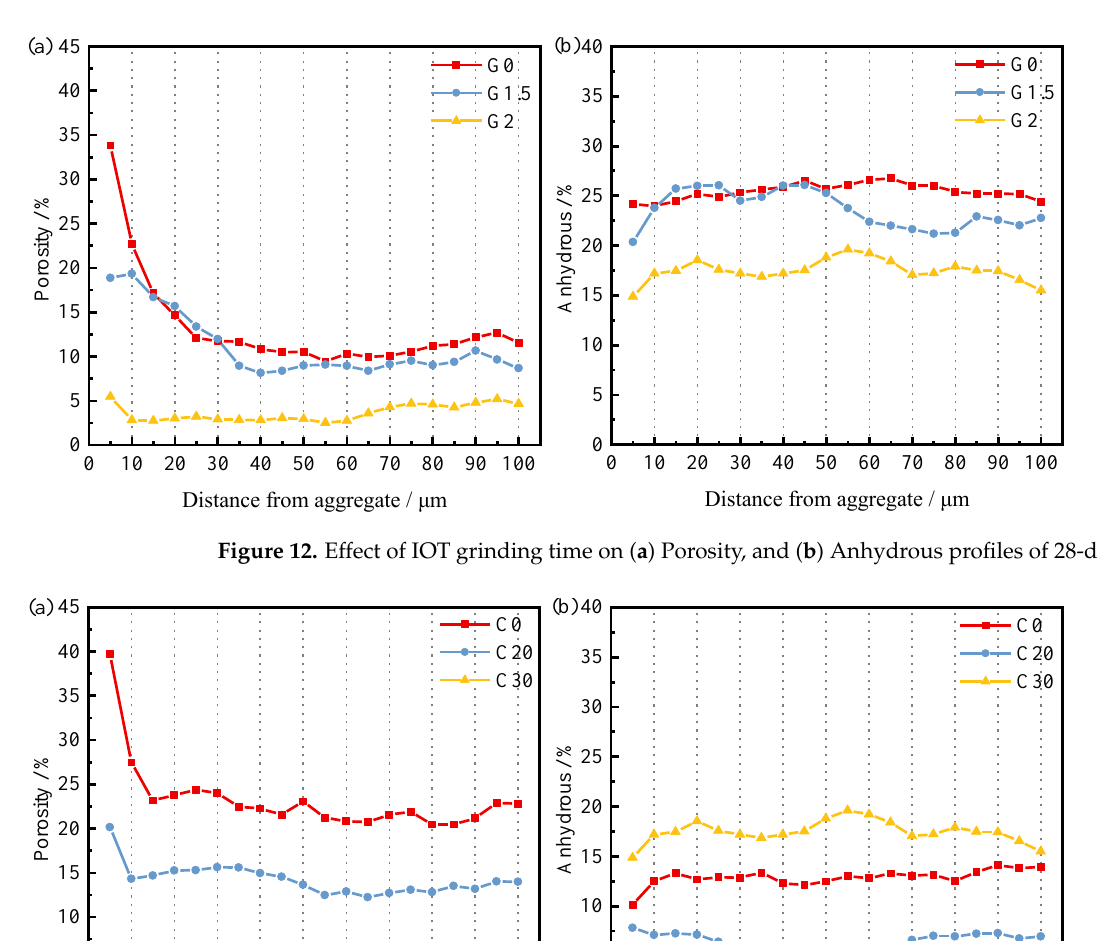
Figure 13. Effect of SCMs content on ( a ) Porosity, and ( b ) Anhydrous profiles of 28-d